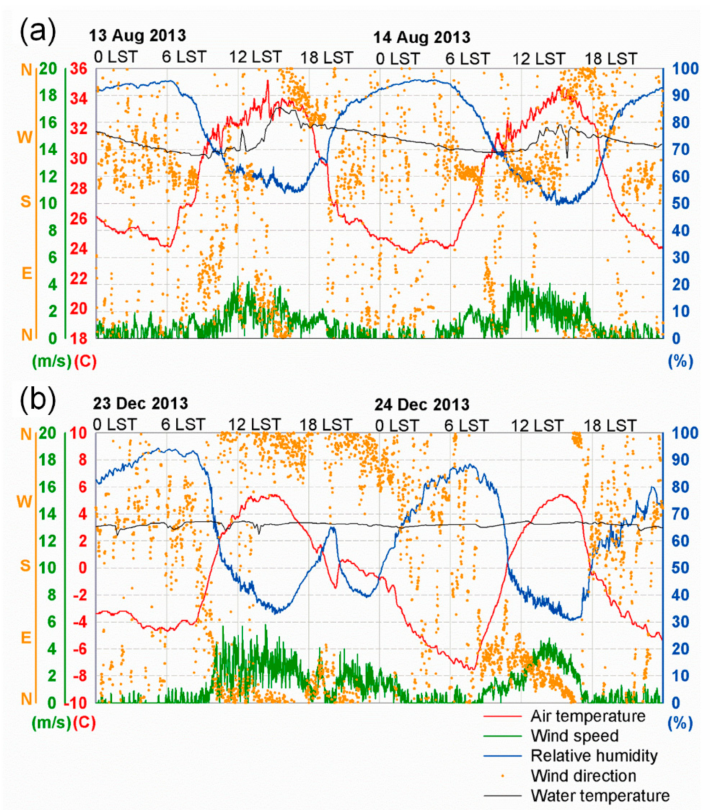
Figure 3. Time series of observed air temperature, relative humidity, wind speed, wind direction, and water temperature for ( a ) Case1 (13 August 2013) and ( b ) Case2 (23 December 2013) at